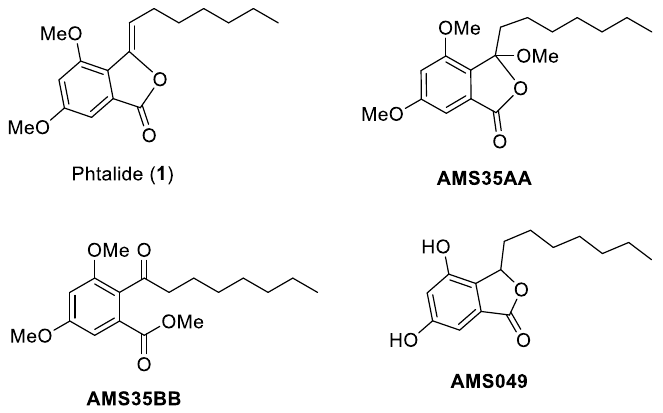
Figure 1. Chemical structures of cytosporone analogs.